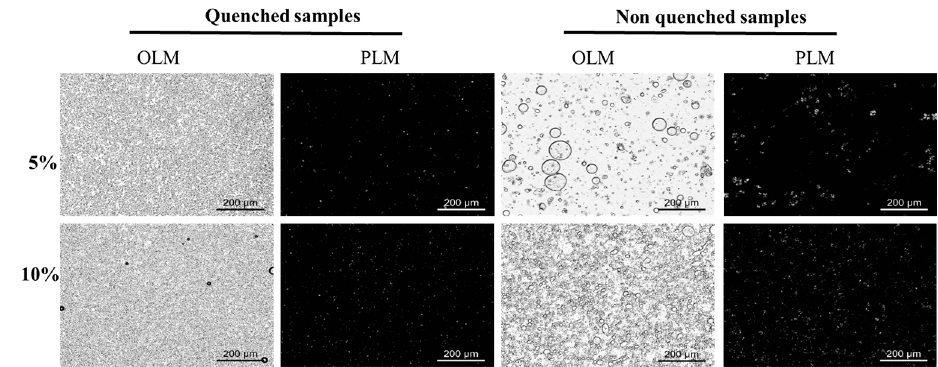
Figure 6. Bright-field and polarized light images of BW50:ZLW50 margarine, respectively.